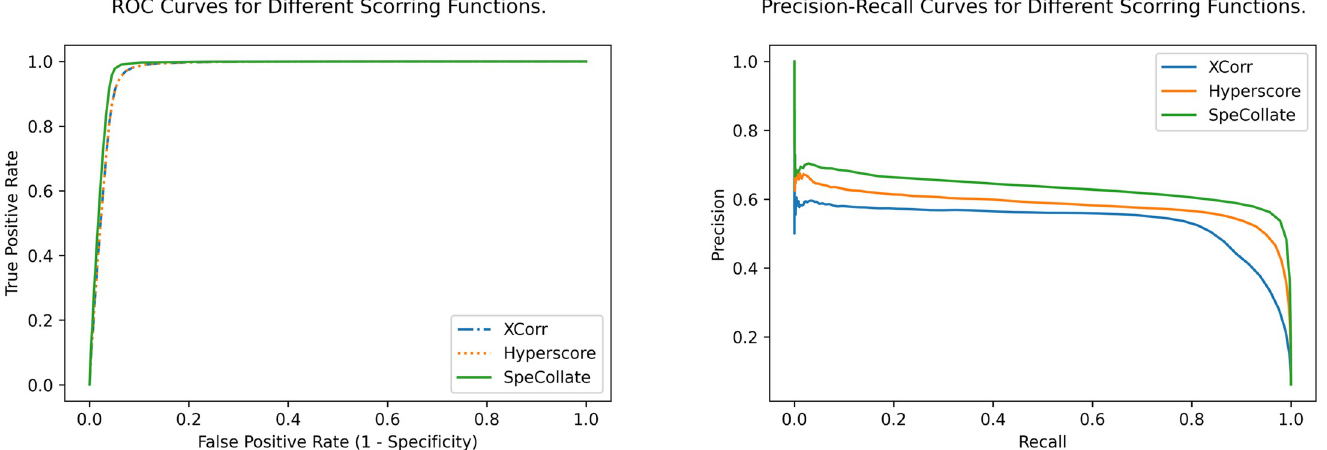
Fig 7. ROC (left) and Precision-Recall (right) curves for closed search. Both ROC curves and Precision-Recall curves for SpeCollate, XCorr, and Hyperscore show that SpeCollate performs best for all cutoff values for closed search ( ± 0.5 Da precursor mass tolerance).